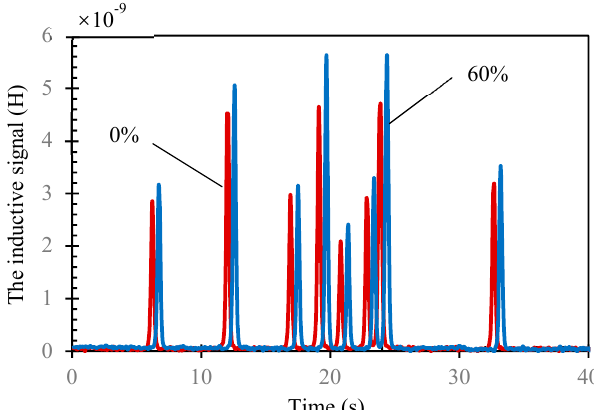
Figure 6. The inductive signal (subtract the basic inductance value) for 74–88 µ m wear debris mixed with oil passing through coil with 60% magnetic powder (blue line) and without (red line).